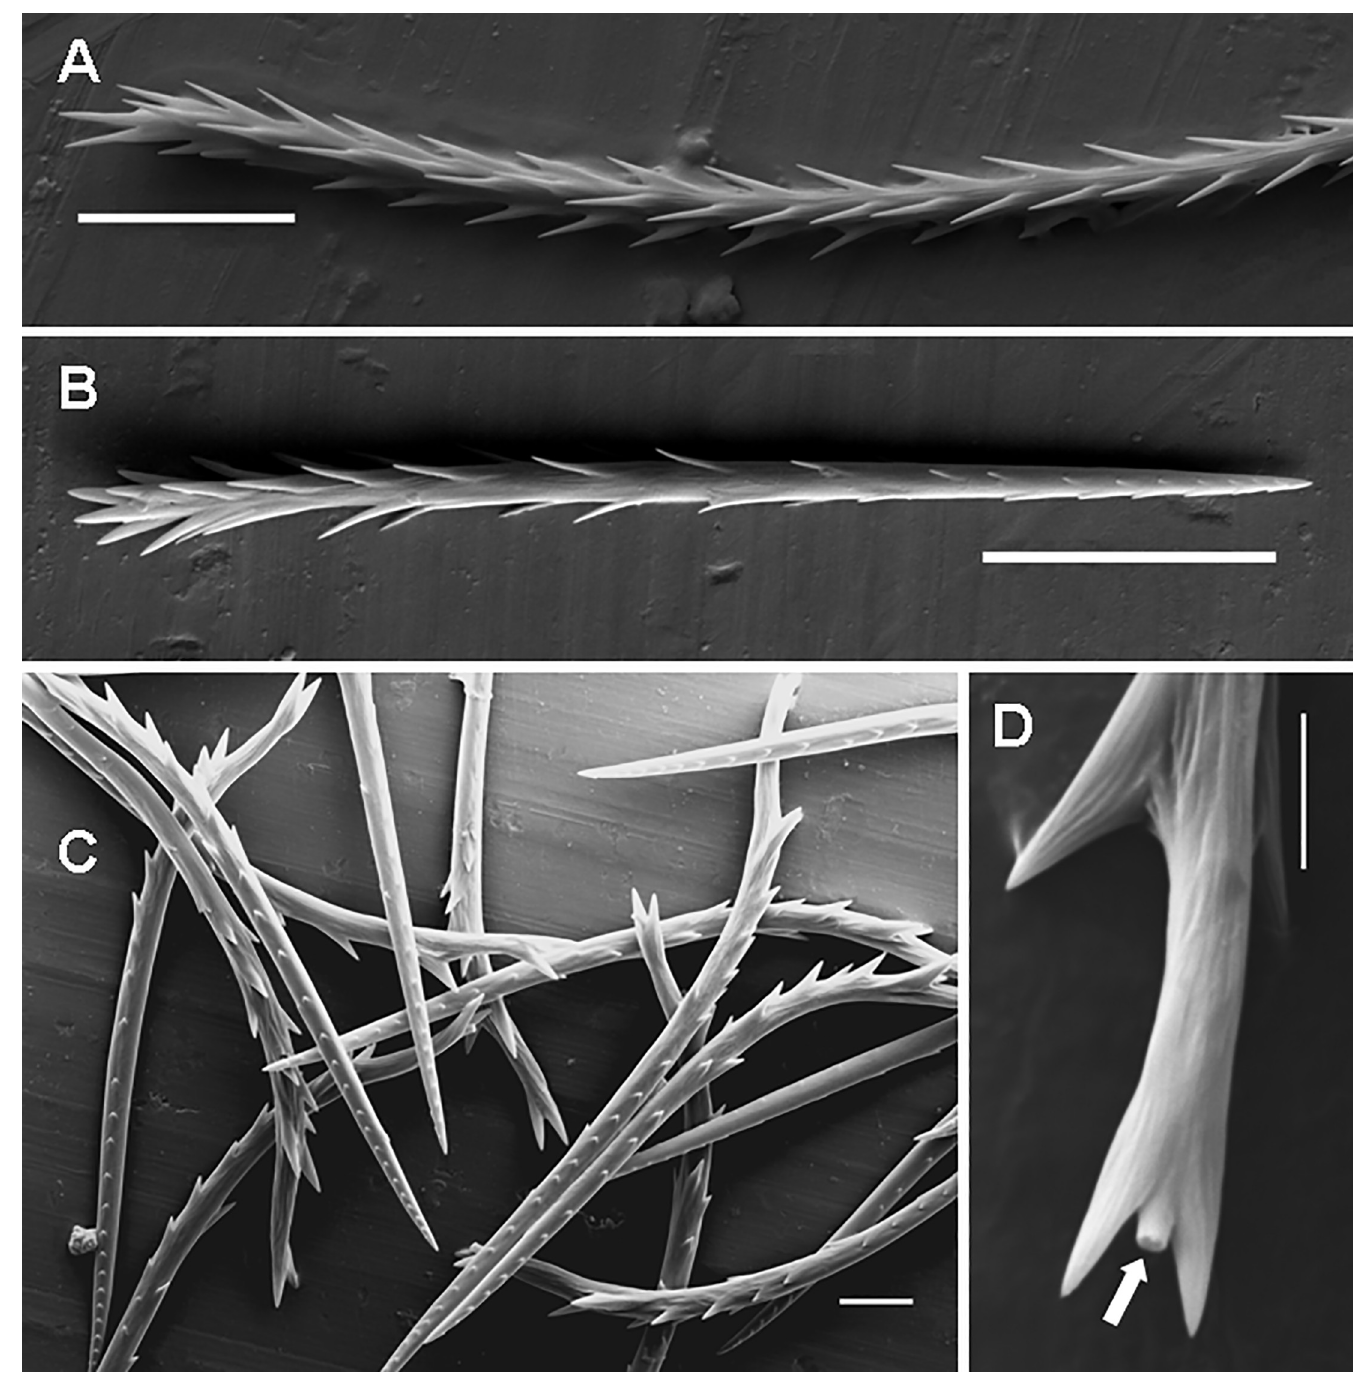
Fig 12. Urticating setae of type III and IV. (A) Theraphosa blondi , female. Long seta of type III, basal section, total length 0.28–0.32. Scale bar = 20 μ m. (B) Theraphosa blondi , female. Short seta of type III, total length 0.07–0.08. Scale bar = 20 μ m. (C) Chromatopelma cyanopubescens , female. Type IV with reversed barbs in the basal section and reversed denticles in the apical section. Scale bar = 10 μ m. (D) Chromatopelma cyanopubescens , female. Type IV, basal end, the arrow shows the connection to a supporting stalk, located between the last two basal barbs. Scale bar = 5 μ m.